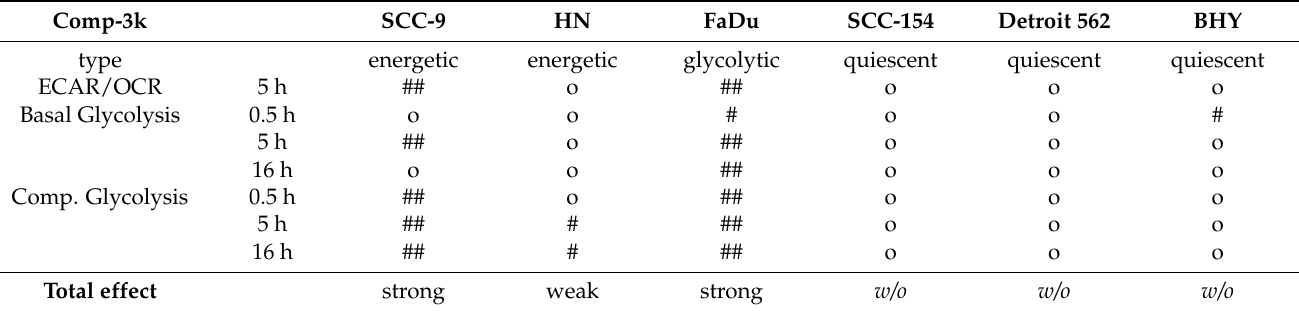
Table 2. Outcomes of Compound 3k treatment on HNSCC cell lines. o: no effect, #: small effect, ##: large effect. Five or more times small or large effect results in total effect “strong”, two to four times small or large effect results in total effect “weak”, zero to one time small or large effects results in total effect “ w/o ” (without effect). Comp.: